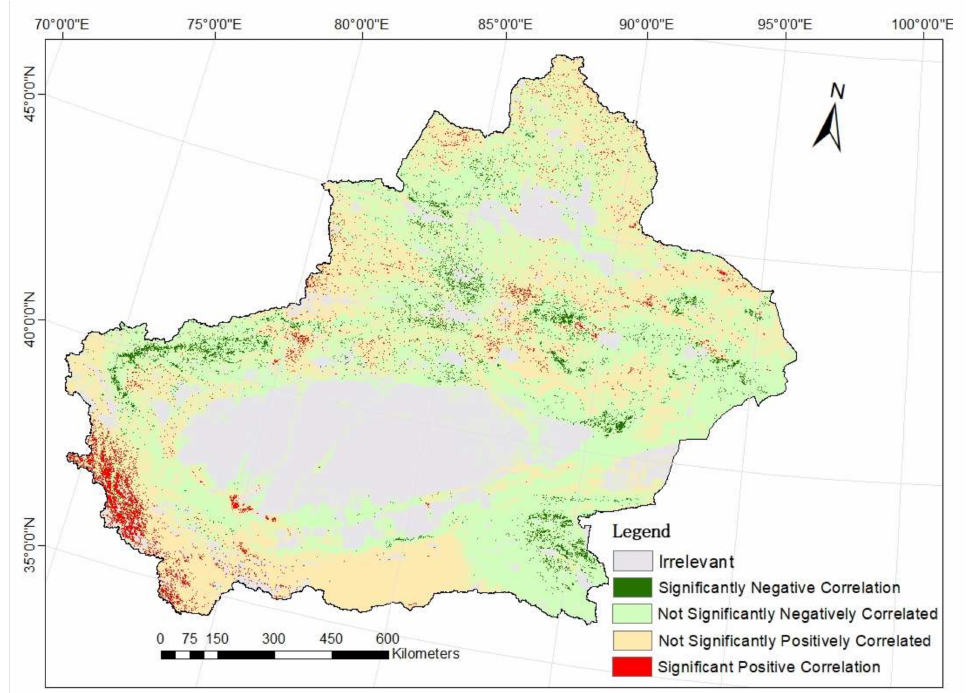
Figure 7. Partial correlations between annual accumulated temperature and NPP.